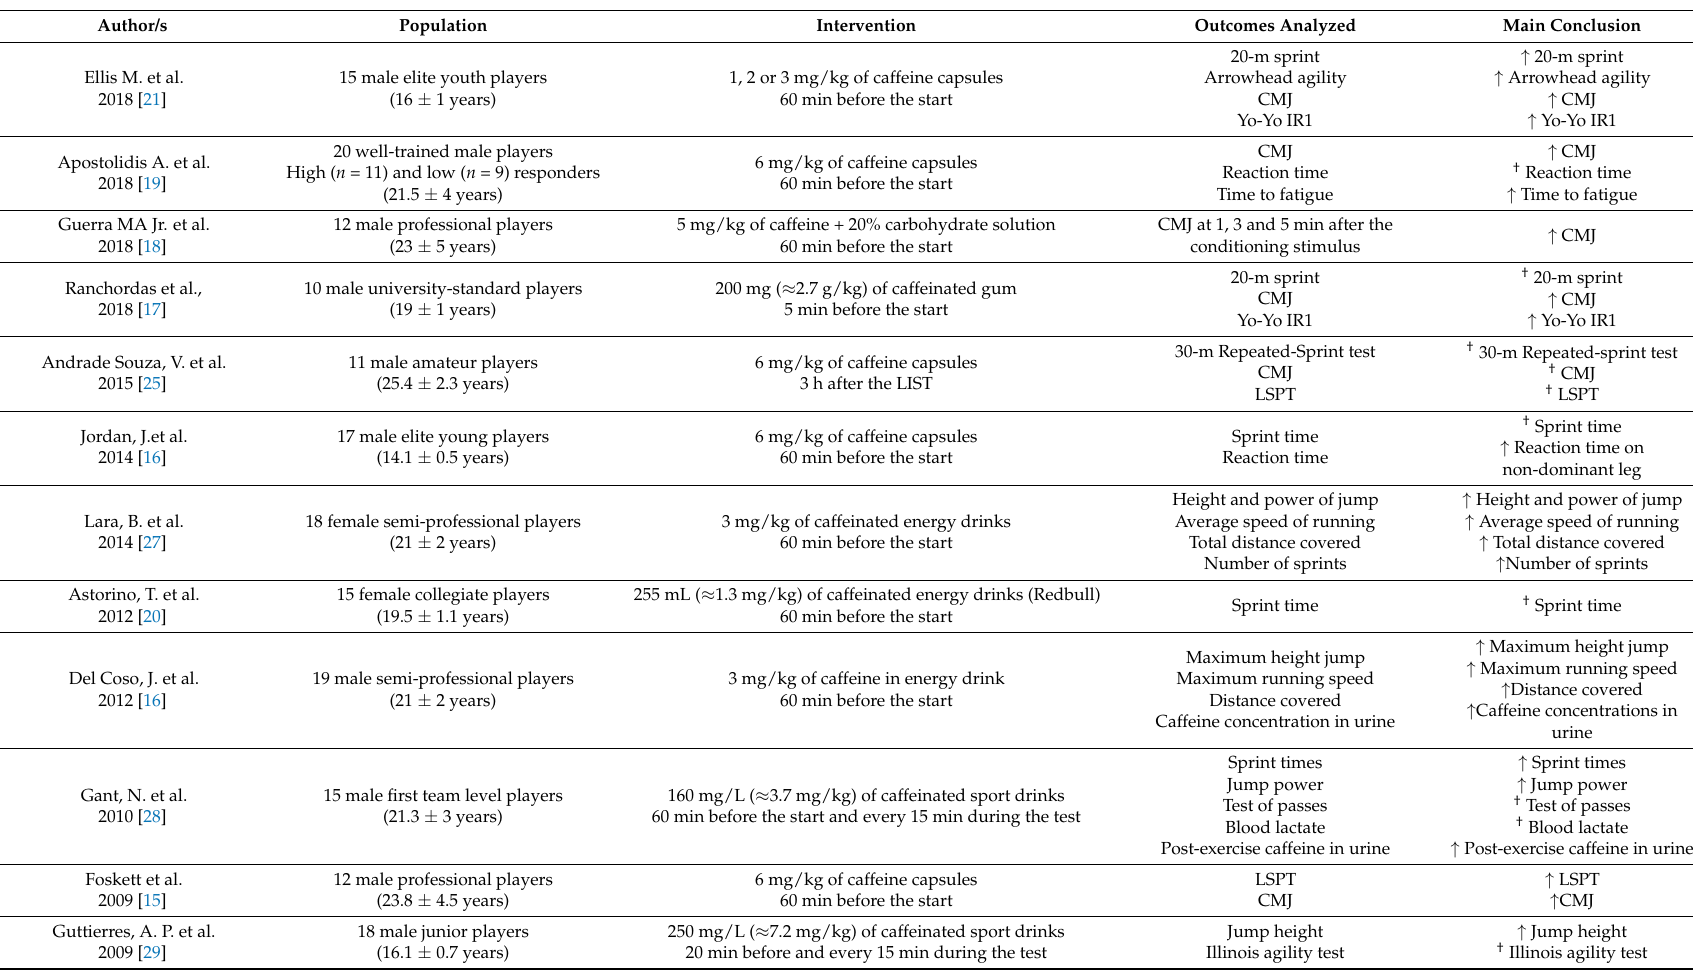
Table 1. Summary of studies included in the systematic review that investigated the effect of caffeine ingestion as compared to a placebo on soccer-specific